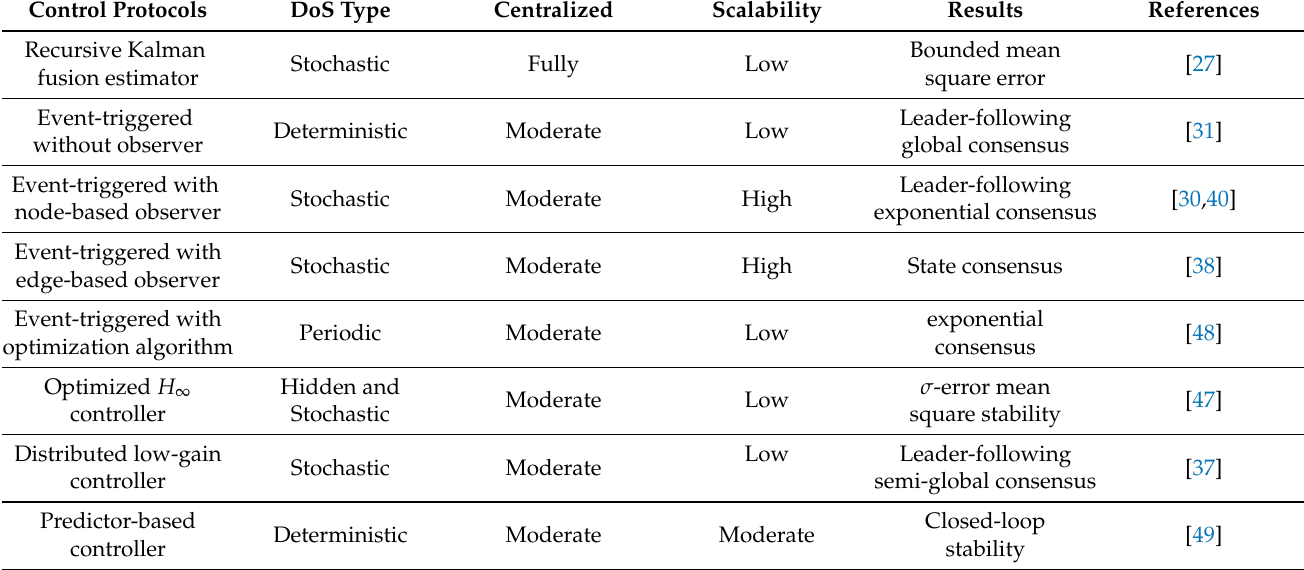
Table 2. Rencent Work on DoS